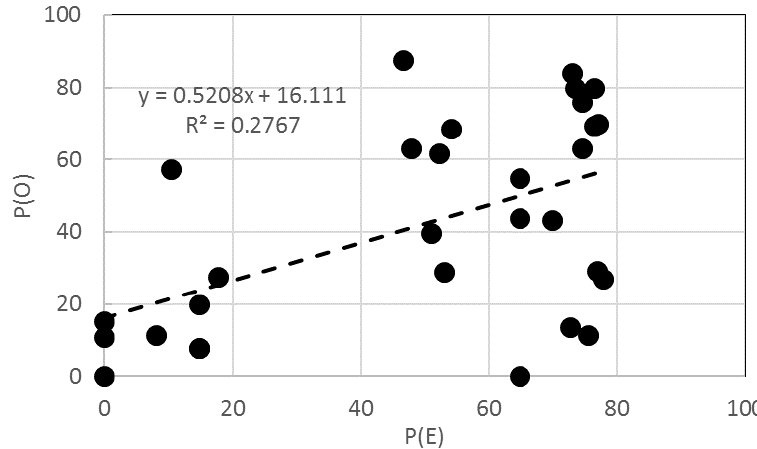
Figure 4. Relationships between the observed and expected toxic effects of 30 binary mixtures of NPs based on the chlorophyll content of algal growth.